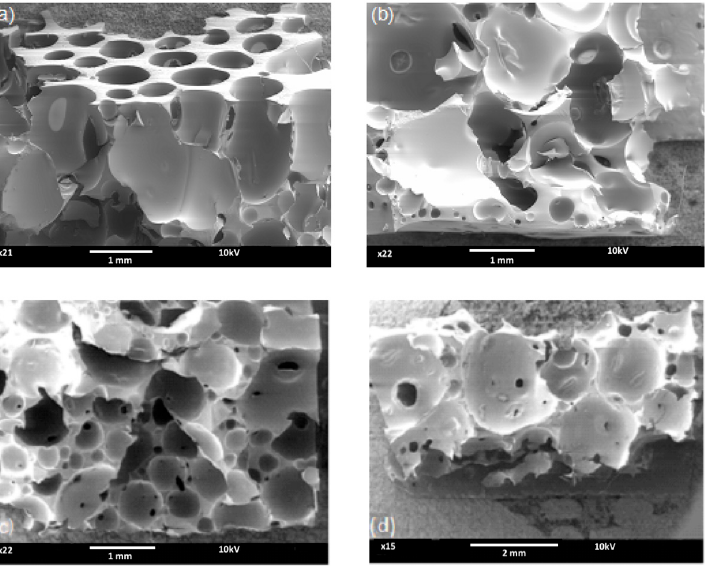
Figure 5. SEM micrographs of PUs before soil degradation: ( a ) PULOA, ( b ) PULOB, ( c ) PUPFOA, and ( d ) PUPFOB.